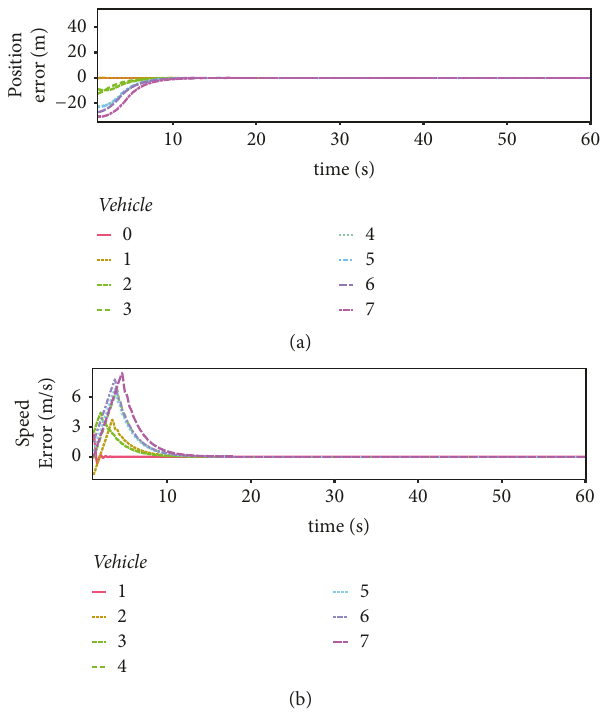
Figure 2: Platoon performance for the initial scenario: (a) the position error 𝑥 𝑖 (𝑡) − 𝑥 0 (𝑡) + 𝑖 ⋅ 𝑠 ; (b) the speed error V 𝑖 (𝑡) − V 0 (𝑡)